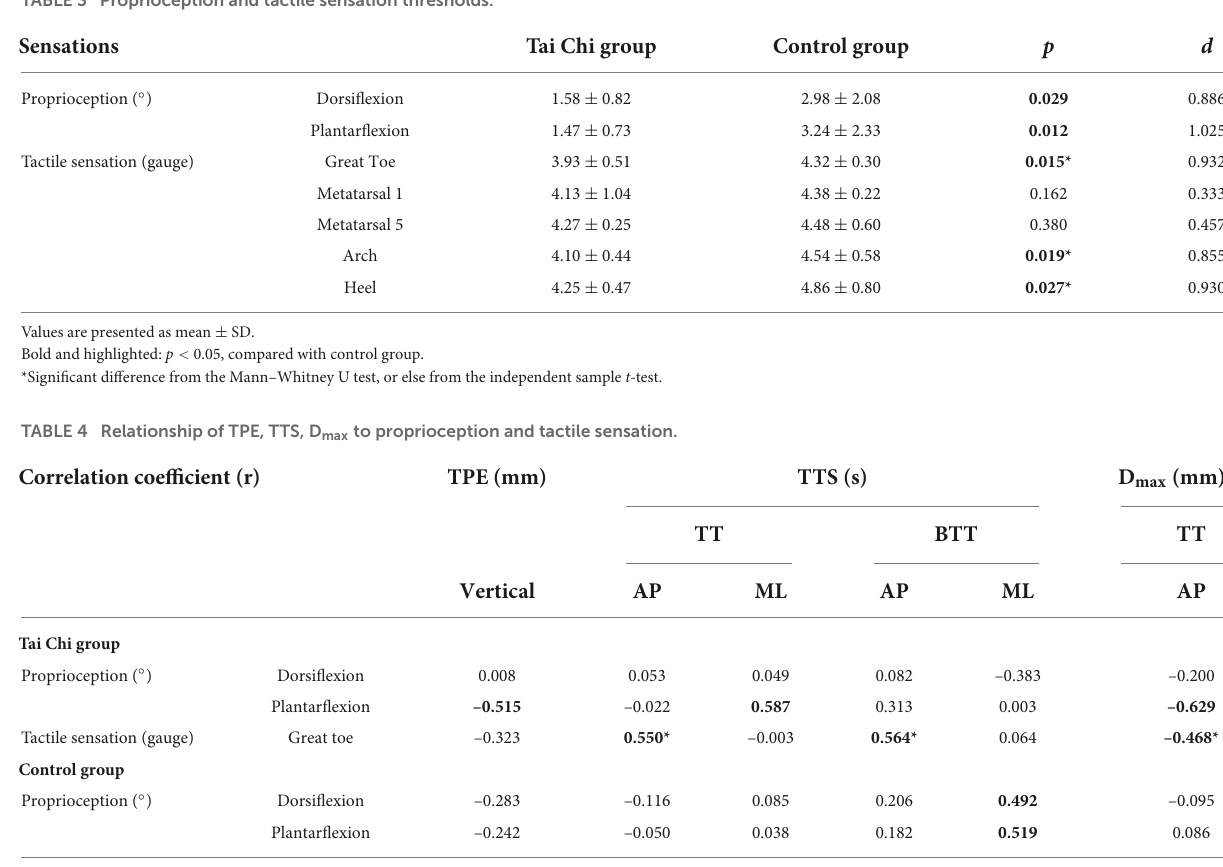
TABLE 3 Proprioception and tactile sensation thresholds.